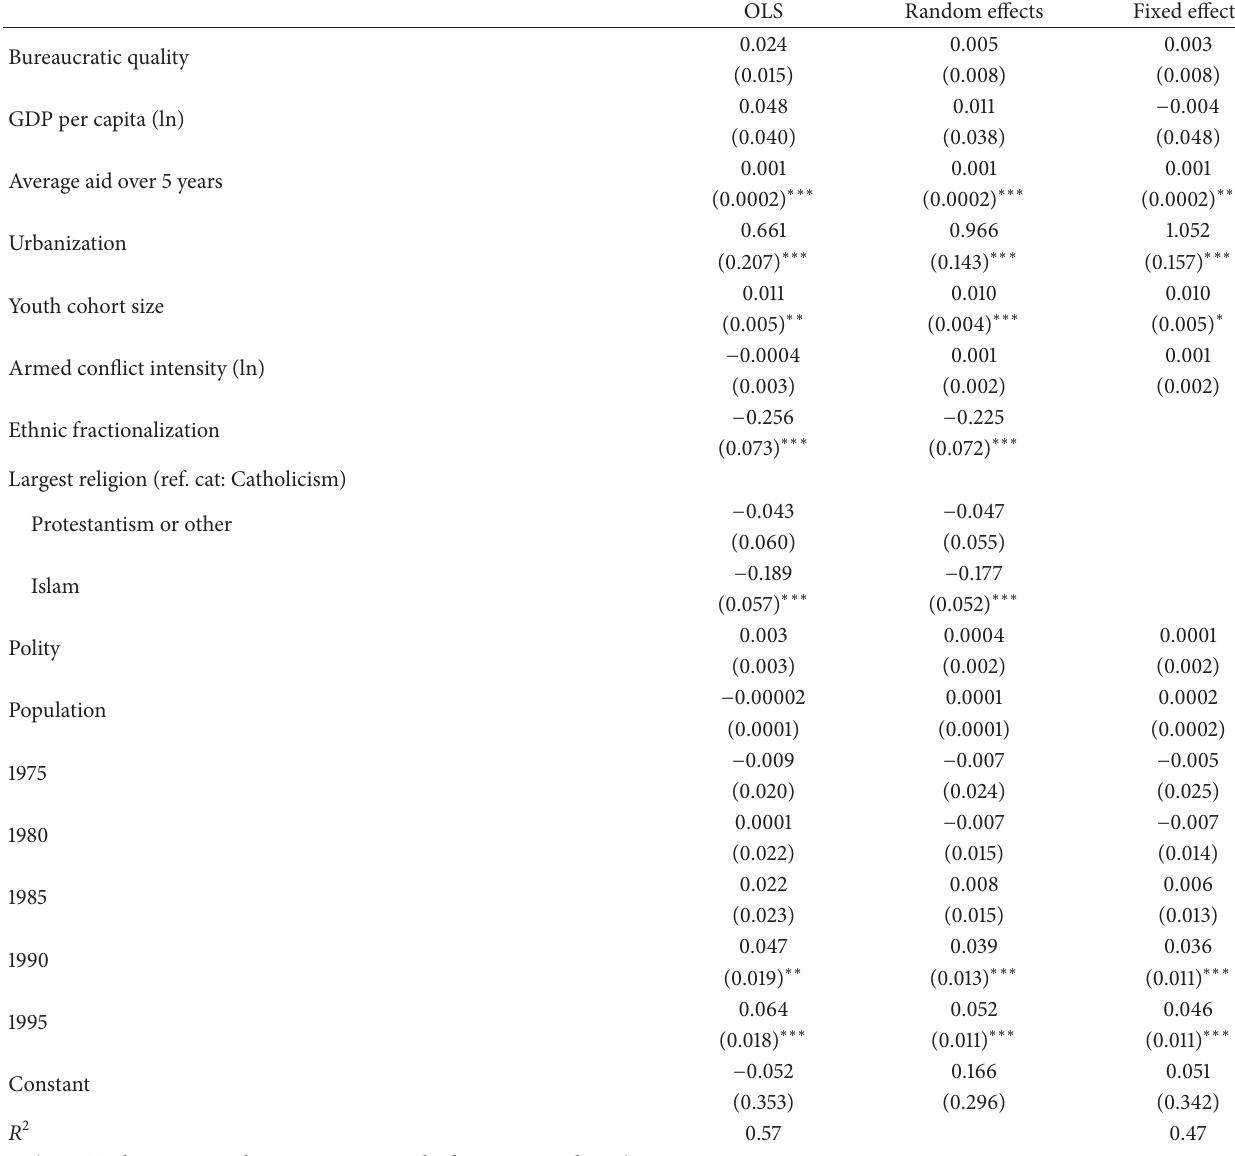
Table 3: Gender parity in secondary education attainment, developing countries: 1970–2010. Alternative measure of democracy: